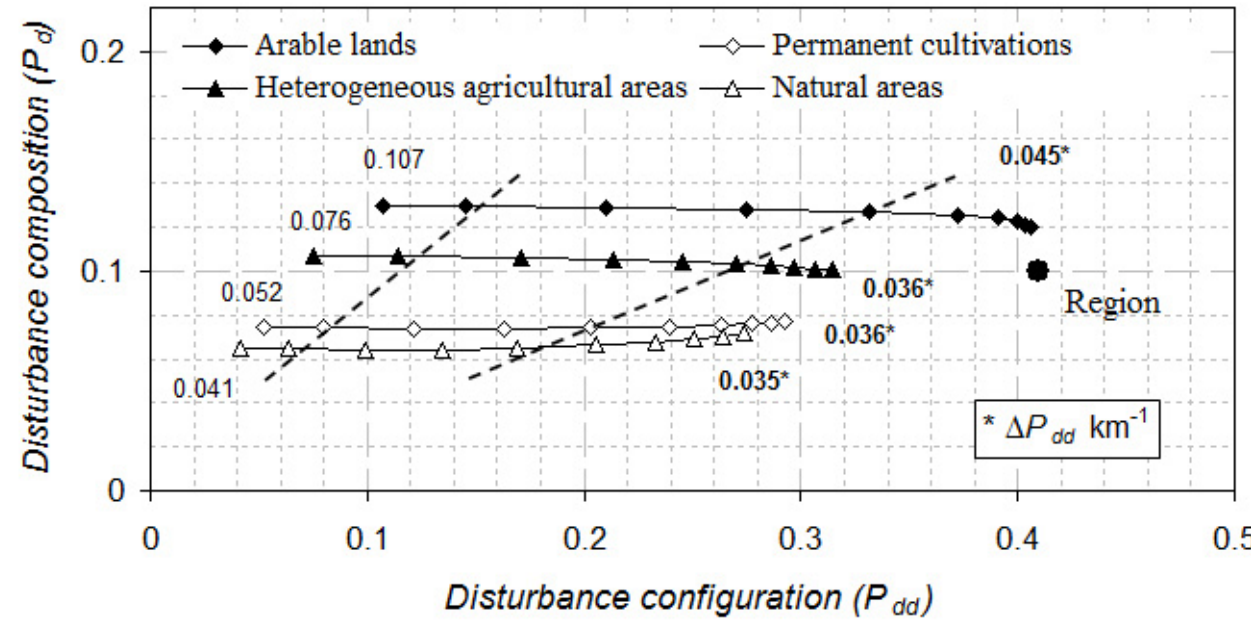
Fig. 3. Disturbance trajectories for the four broad land-use classes of Apulia at multiple scales (10 window sizes) at regional P = 0.10 are represented in the same state space [P , P ] of Fig. 2. Initial P d d dd dd values, cross-scale linear increments ( D P km -1 ) of disturbance configuration (in bold) for each land-use dd disturbance trajectory, and regional convergence point (black dot) are shown. Dashed lines attempt to connect identical window sizes among different land uses to exemplify cross-scale disturbance mismatches, e.g., between arable lands and natural